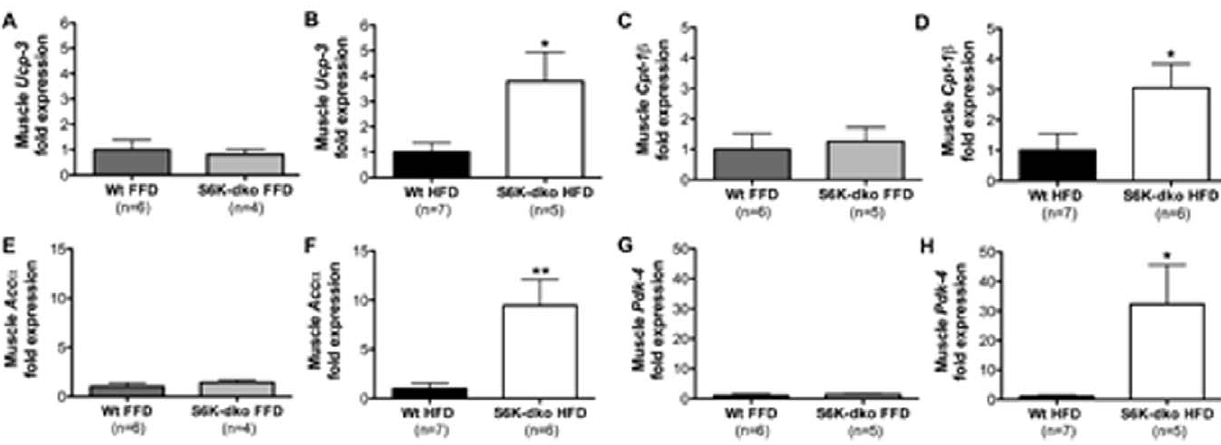
Figure 7. Muscle lipid beta oxidation in S6K-dko is diet regulated. S6K-dko mice fed a high-fat diet have higher muscle lipid beta oxidation, as shown by significantly higher mRNA levels of Ucp-3 (B), Cpt-1 b (D), Acc a (F) and Pdk-4 (H). No such differences were observed in mice fed a fat free diet (A, C, E, G). FFD, fat-free diet; HFD, high-fat diet. Two-tailed t test * P , 0.05, ** P , 0.01.